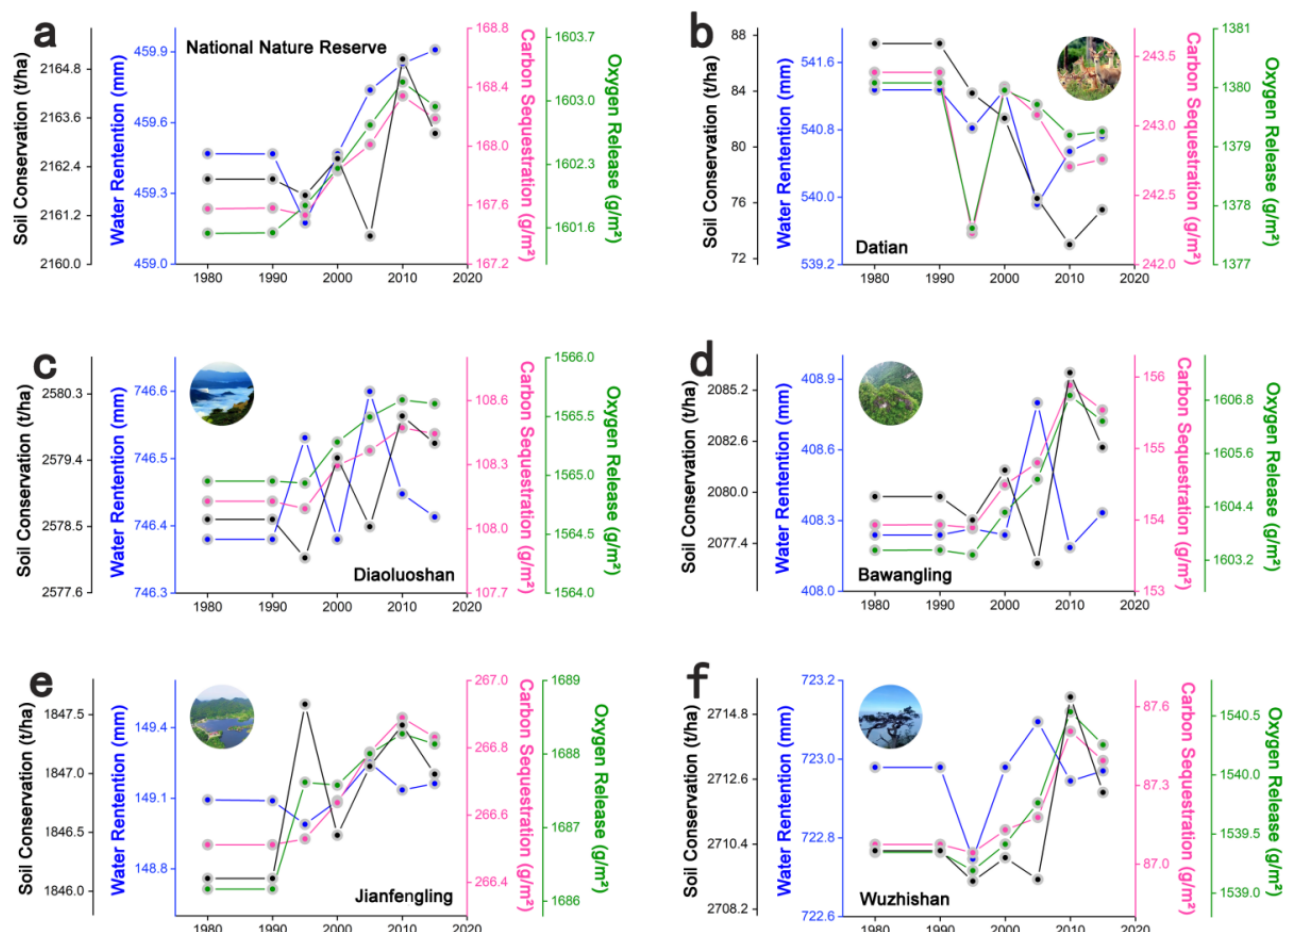
Figure 9. Broken line diagram of the ecosystem service time series of national nature reserves from 1980 to 2015. ( a ) Broken line diagram of the ecosystem service time series of all national nature reserves from 1980 to 2015. ( b ) Broken line diagram of the ecosystem service time series of Datian national nature reserves from 1980 to 2015. ( c ) Broken line diagram of the ecosystem service time series of Diaoluoshan national nature reserves from 1980 to 2015. ( d ) Broken line diagram of the ecosystem service time series of Bawangling national nature reserves from 1980 to 2015. ( e ) Broken line diagram of the ecosystem service time series of Jianfengling national nature reserves from 1980 to 2015. ( f ) Broken line diagram of the ecosystem service time series of Wuzhishan national nature reserves from 1980 to 2015.